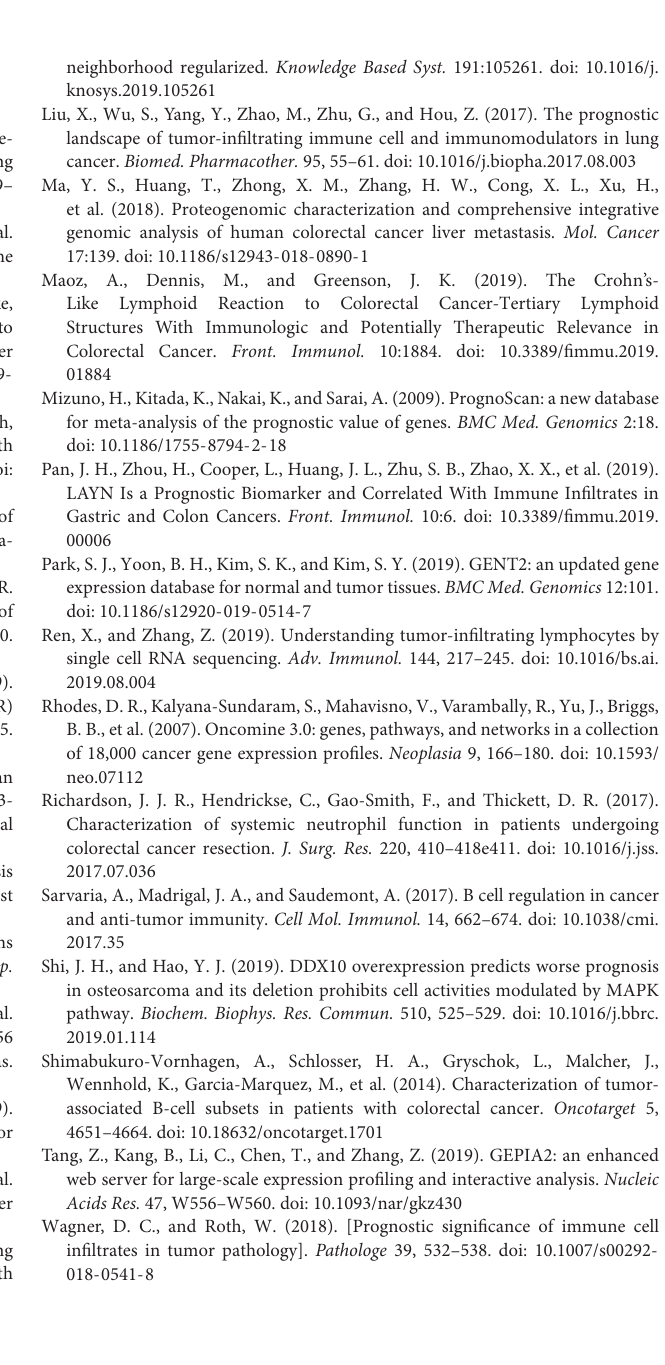
Supplementary Figure 1 | The flow chart of our analysis